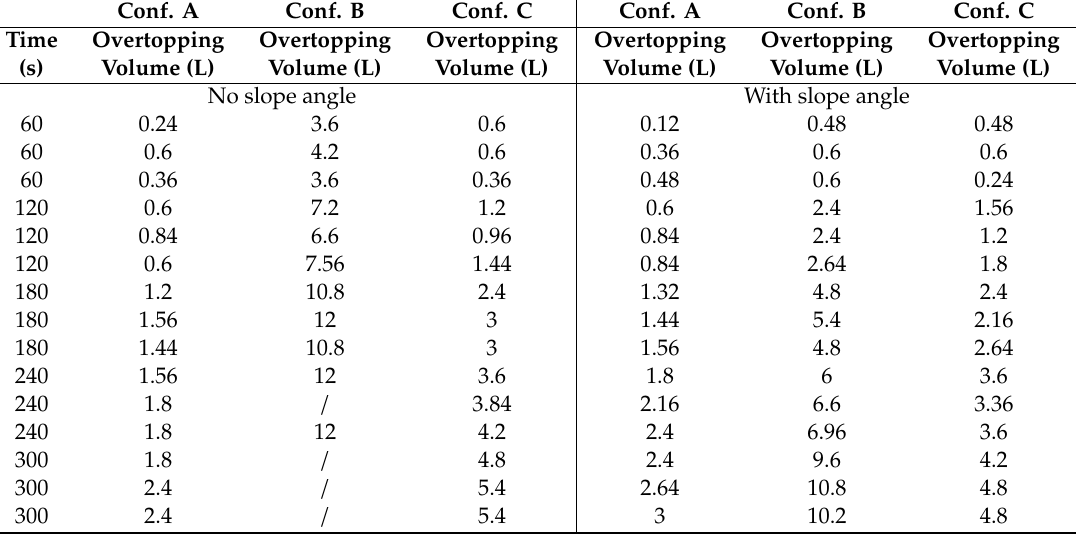
Table 6. Experimental testing parameters collected for JONSWAP waves with and without slope angle.